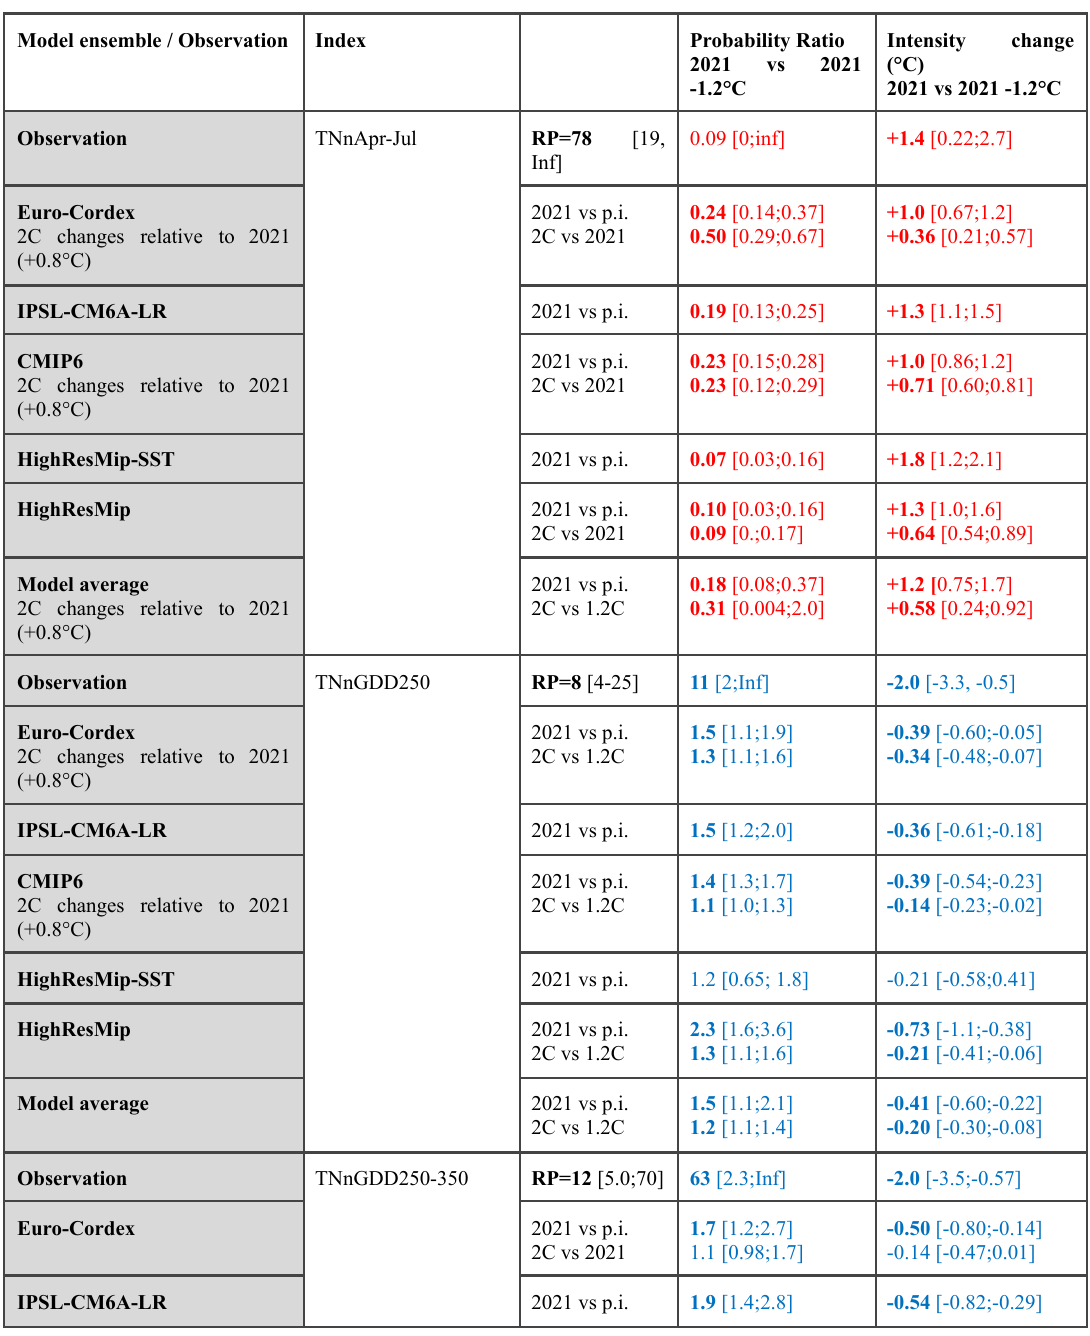
Table 3. Change in extreme value statistics for all model ensembles and observations, with the GEV model fitted from data over the 1951– 2020 period for the past trend estimates and over the 2000–2050 period for future trends (when estimating the changes for a 2 ◦ C warming above preindustrial levels). We assume here that the preindustrial (p.i.) global warming level is 1.2 ◦ C cooler than the 2021 one; and therefore, the 2 ◦ C warming level is reached when the warming is 0.8 ◦ C above the current level. In each row, the values of the probability ratio (the ratio between inverse return periods) are shown, as well as the intensity change, obtained by using the same return period threshold as in the observations, together with their 95% confidence levels as obtained from a bootstrap estimate using 1000 samples. Numbers in blue indicate a decrease of TN and in red an increase of TN. The last row indicates changes for a 2 ◦ C warming level. Boldface numbers indicate statistical significance against a “no change”